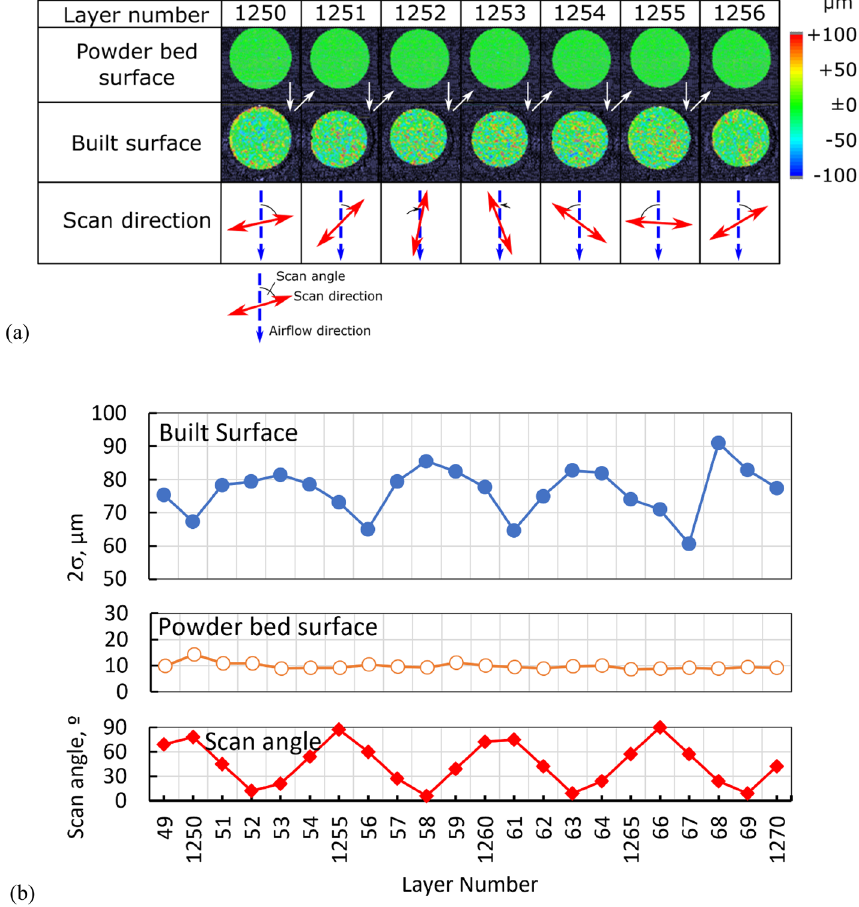
Figure 1. Change in monitoring images of the surface morphologies of the powder bed and the built part. ( a ) Change in the surface morphology of the powder bed and built part fabricated at the condition; P = 200 W, v = 665 mm/s, h = 0.1 mm, z = 0.05 mm, and E = 30.1 J/mm 3 ) from the 1250th to 1256th layer. ( b ) The values of